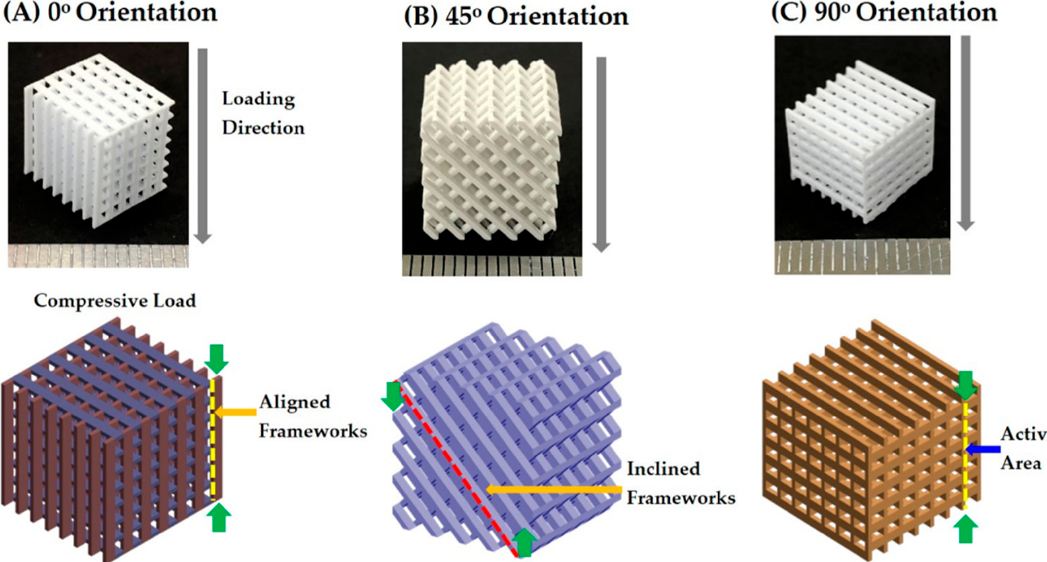
Figure 13. Optical images of the porous CaP scaffolds with a pore orientation of 0 ◦ /90 ◦ , which were compressed at the loading directions of ( A ) 0 ◦ , ( B ) 45 ◦ , and ( C ) 90 ◦ (building direction). Schematic diagrams represent the frameworks placed under compressive or bending stress.